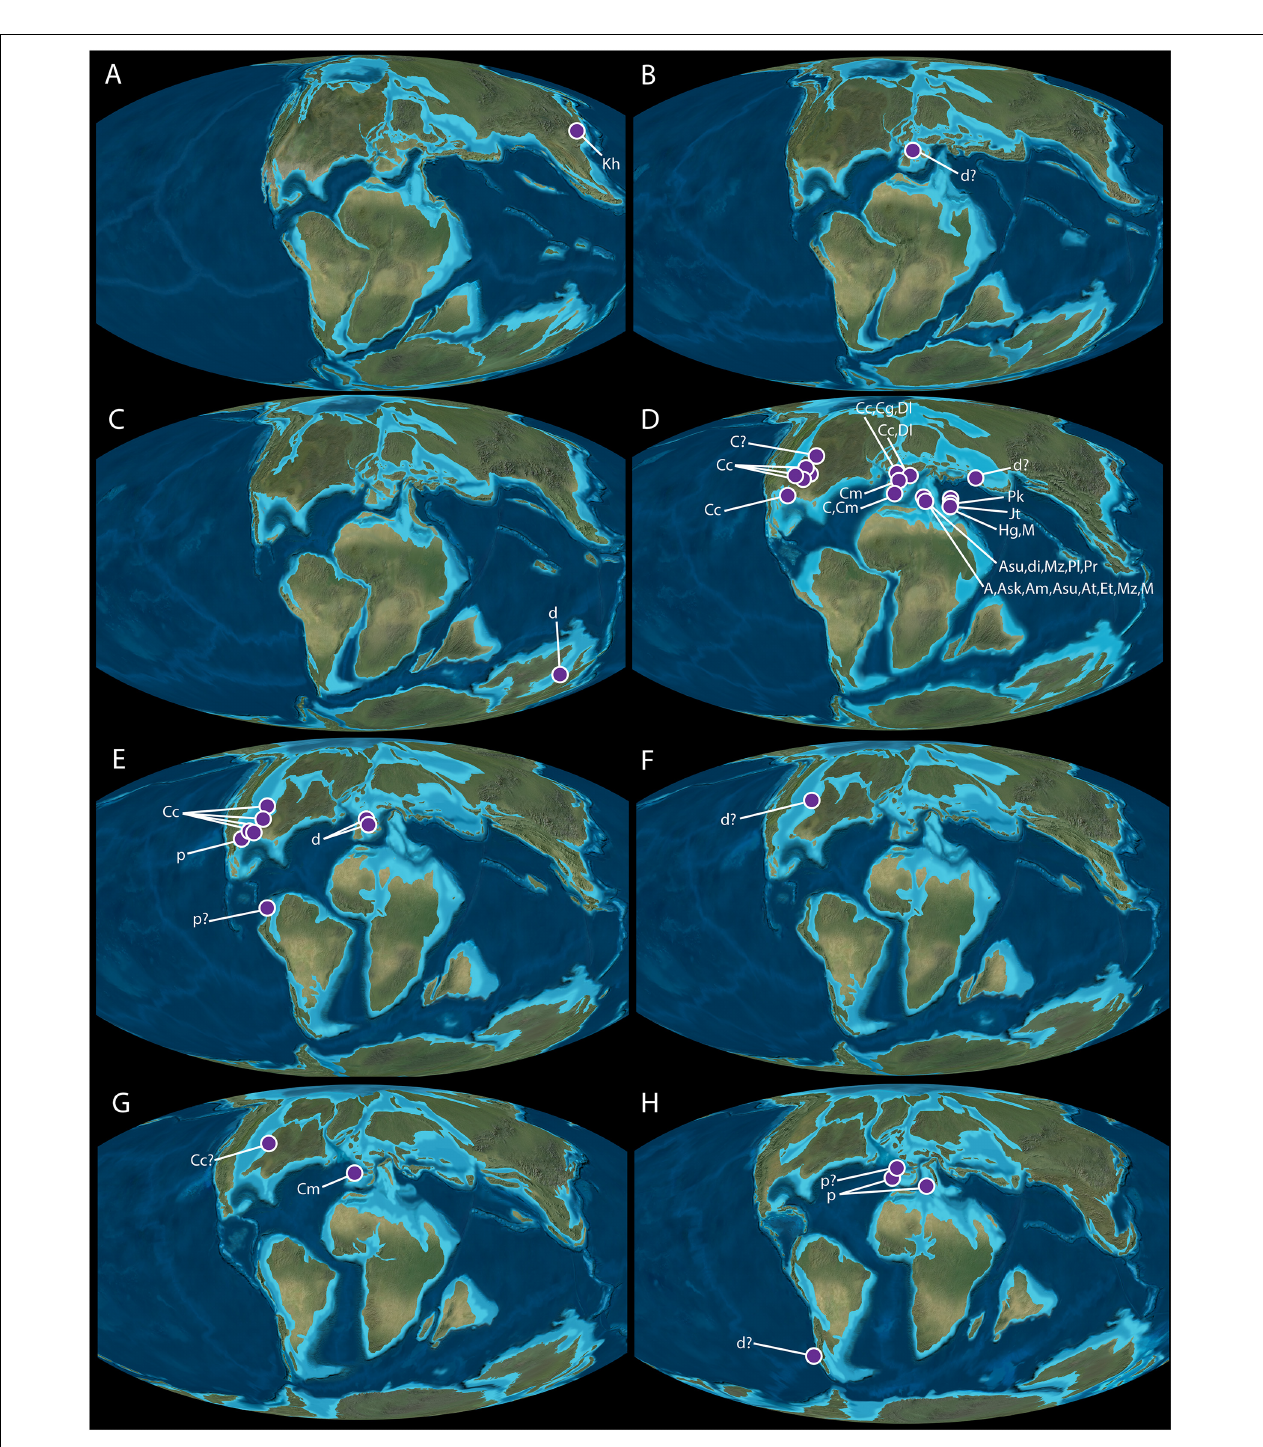
FIGURE 2 | Paleogeographic distributions of dolichosaurs according to stage of Cretaceous. (A) Hauterivian (132.9-129.4 My); (B) Barremian (129.4-125.0 My); (C) Albian (113.0-100.5 My); (D) Cenomanian (100.5-93.9 My); (E) Turonian (93.9-89.8 Ma); (F) Coniacian (89.8-86.3 Ma); (G) Santonian (86.3-83.6 Ma); (H) Campanian/Maastrichtian (83.6-66.0 My). A, Adriosaurus sp.; Am, Adriosaurus microbrachis ; Ask, Adriosaurus skrbinensis ; Asu, Adriosaurus suessi ; At, Acteosaurus tommasinii ; C, Coniasaurus sp.; Cc, Coniasaurus crassidens ; Cg, Coniasaurus gracilodens ; Cm, Carentonosaurus mineaui ; d, dolichosaur; Dl, Dolichosaurus longicollis ; Et, Eidolosaurus trauthi ; Hg, Haasiasaurus gittelmani ; Jt, Judeasaurus tchernovi ; Kh, Kaganaias hakusanensis ; M, Mesoleptos sp.; Mz, Mesoleptos zendrinii ; Pk, Pontosaurus kornhuberi ; Pl, Pontosaurus lesinensis ; Pm, Primitivus manduriensis ; Pr, Pontosaurus ‘from the reef’ - unnamed; p, pythonomorph lizard (because of their proximity to each other, all the localities in France, and the United States are not shown). Paleogeographic maps from Blakey, R., ©2016 Colorado Plateau Geosystems Inc., used with permission.